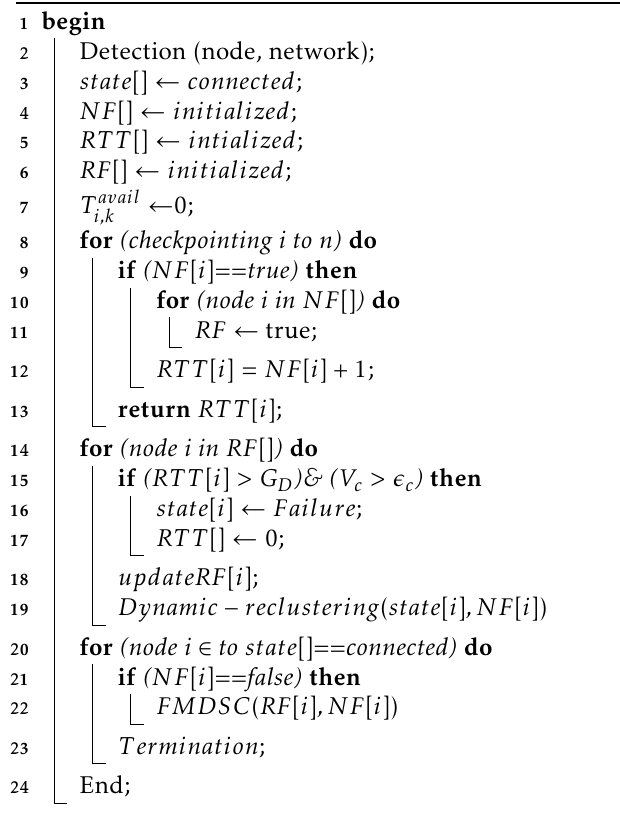
Algorithm 3: Fault Aware